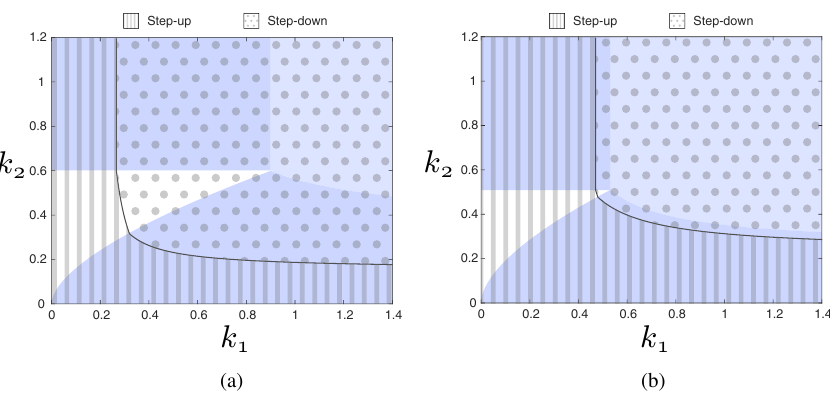
Figure 10. Step-down and step-up borders with constant duty cycles: ( a ) d = 0.4, ( b ) d = 0.49.